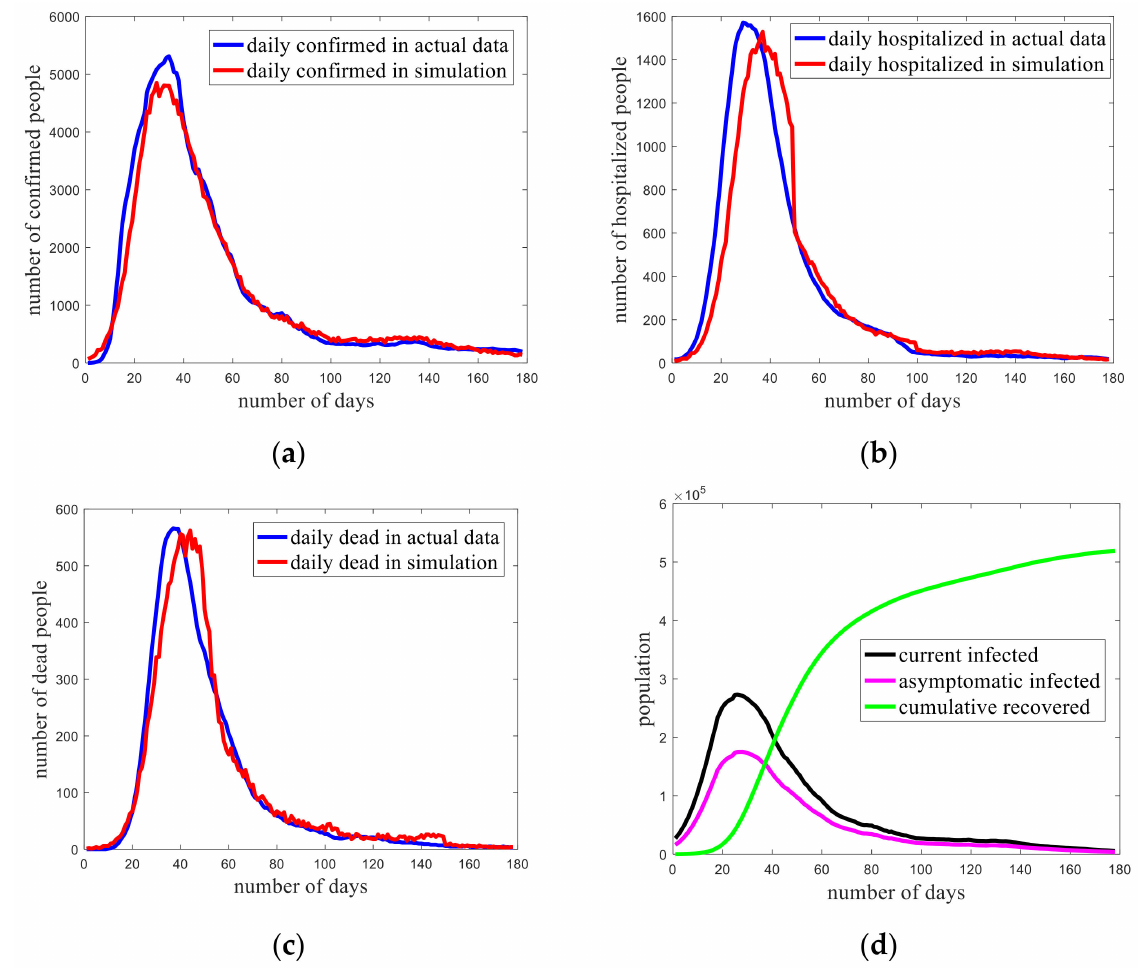
Figure 3. ( a ) The comparison result of New York City (NYC) in terms of daily confirmed. ( b ) The comparison result of NYC in terms of daily hospitalized. ( c ) The comparison results of NYC in terms of daily dead. ( d ) The trend of infected numbers and recovered